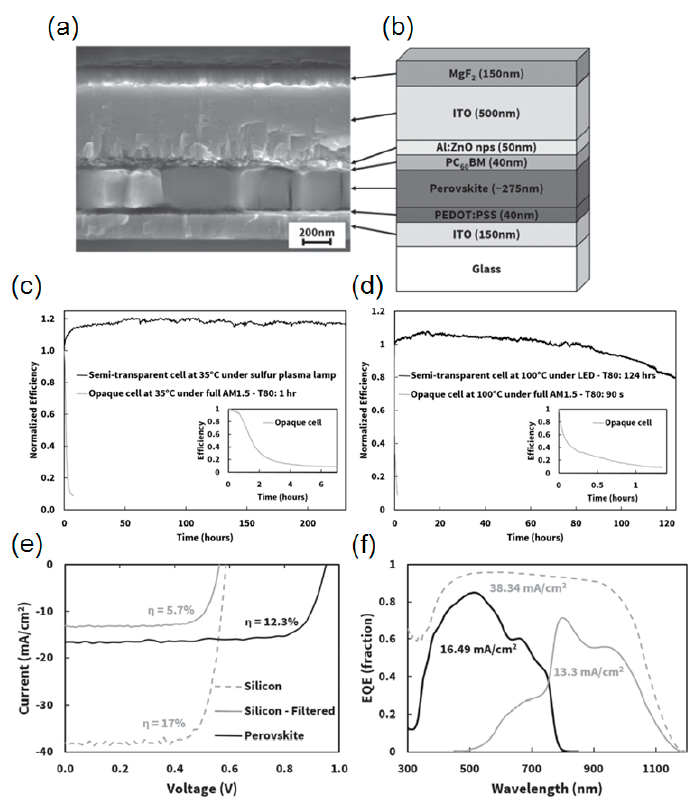
Figure 6. ( a ) A cross-sectional SEM image and ( b ) illustrative schematic of the